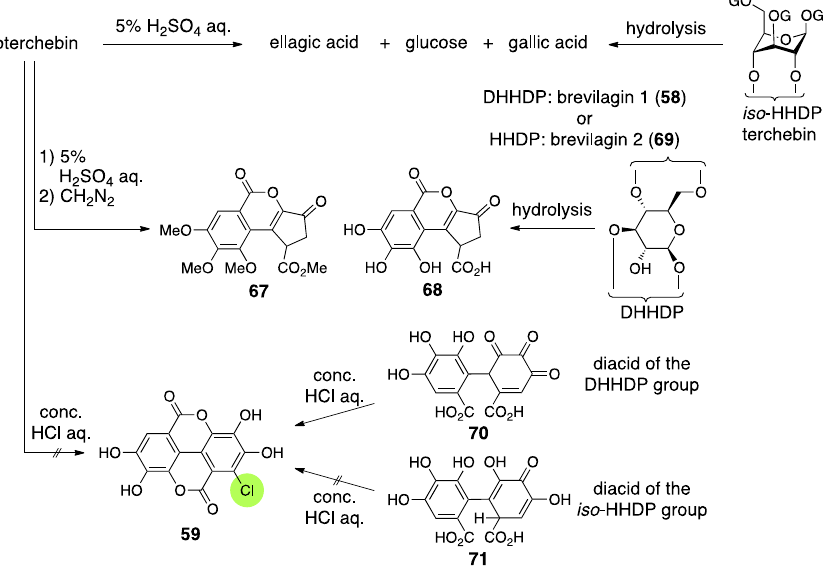
Figure 28. The transformations used for the determination of the structure 65 .